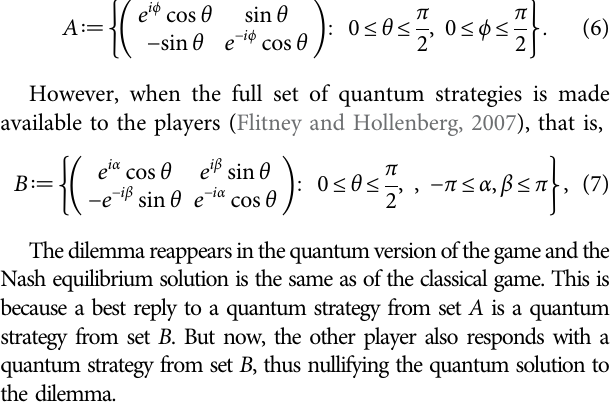
Frontiers in Arti fi cial Intelligence |